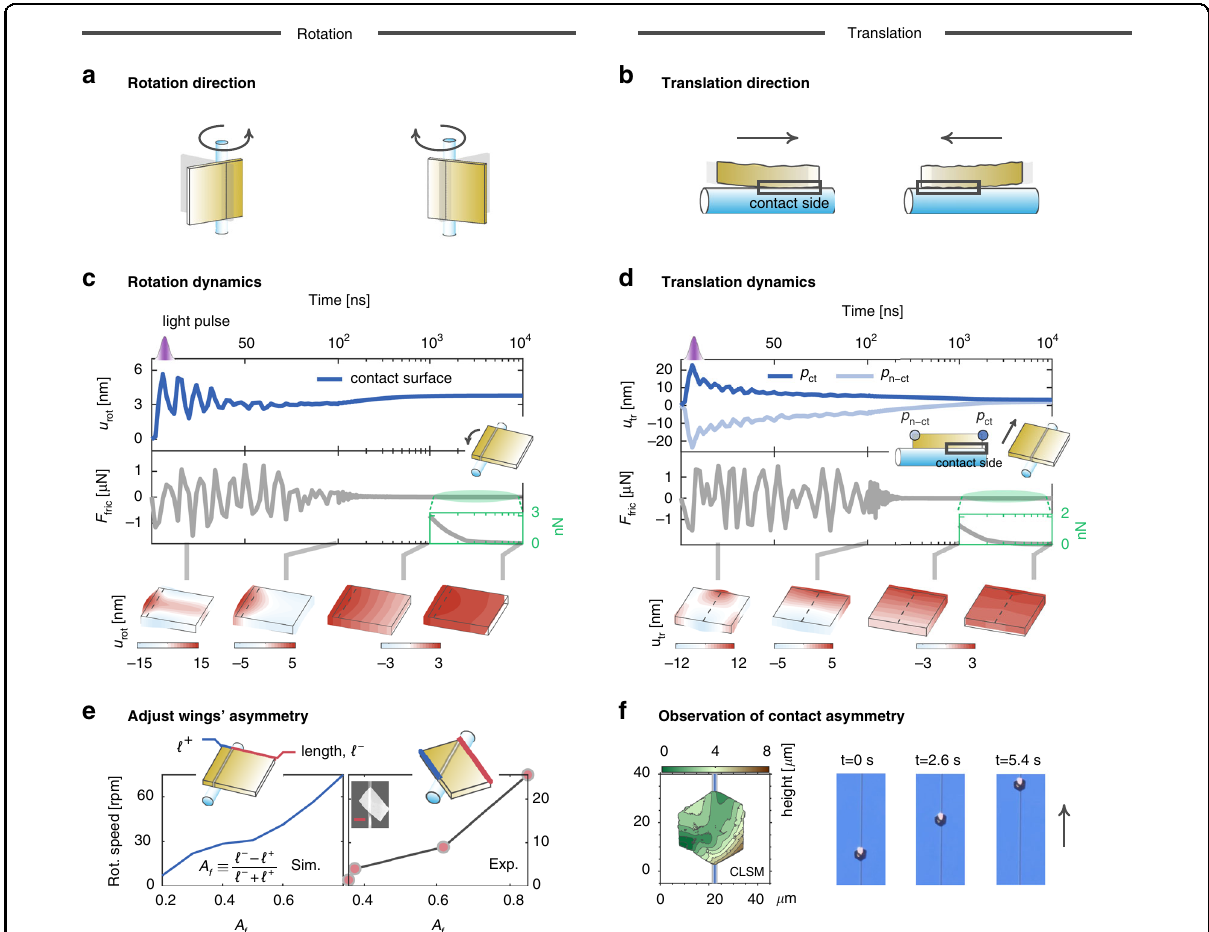
Fig. 4 Mechanism of spiral motion of gold plates. The spiral motion consists of two degrees of freedom — rotation ( a , c , e ) and translation ( b , d , f ). a , b . Sketch of rotation ( a ) and translation ( b ) directions of gold plates and of their dependencies on wings ’ and contact-surface ’ s asymmetries, respectively. c , d Simulation results of (1) sliding displacements (top panels) and (2) friction forces (middle panels) as functions of time for square gold plates driven by a single laser pulse, and of (3) displacement pro fi les at different time (lower panels). The square plates have 30-nm thickness and 10-µm side length; the frictional sliding resistance is 1.5 µN; the life time of the elastic waves is 20ns; the fi ber has a diameter of 1.8µm. The pulsed optical absorption has a 100-mW peak power and a 3-ns width, and its spatial distribution is speci fi ed in Eq. (5.1) in the Supplementary Material. Moreover, in the rotation ( c ) case, the two wings of the plate have unequal lengths, 8 µm and 2 µm, wherein the translation freedom is locked due to the absence of the contact asymmetry. In the translation ( d ) case, the two wings are of equal length to lock the rotation freedom, and the contact surface situates in the half side of the plate. The temperature distributions at different time in the plate are provided in Figs. S11B and S12B in the Supplementary Material. e Simulated (left) and measured (right) rotation speeds as functions of wings ’ asymmetry factor A f . The repetition rate of laser pulses is 2.04-kHz. Scale bar: 4µm. f Confocal laser scanning microscopy image (left) and temporal sequencing of optical images (right) of a hexagonal gold plate on a micro- fi ber, evidencing the direct correlation between the contact asymmetry and the translation in Fig. 4f shows that the translation direction points from the non-contact side to the contact side. We numerically reproduce the same observation in Fig. 4d. Speci fi cally, the upper panel of Fig. 4d contrasts the temporal evolu- tion of the translation displacements of two points on the non-contact ( P ) and contact ( P ) sides, respectively, n − ct ct and shows that the stabilized translation direction points from the P point to the P point. n − ct ct The dependence of the translation direction on the con- tact asymmetry can be appreciated by analyzing the friction force (see the middle panel in Fig. 4d). First, in the initial